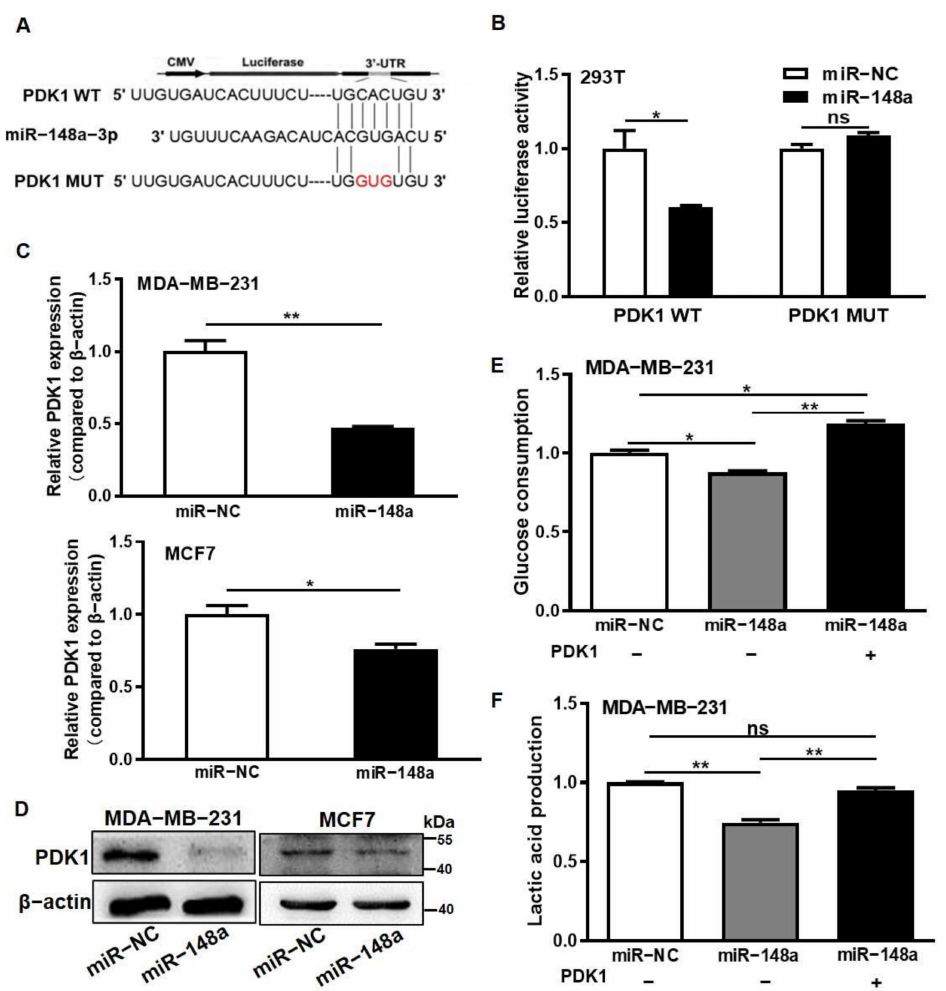
Figure 2. miR-148a was identified for directly suppressing PDK1 expression and inhibiting gly- cometabolism. ( A ) The PDK1 3 (cid:48) -UTR wild-type (WT) and mutant (MUT) reporter constructs con- taining miR-148a-targeting sequences are shown. ( B ) PDK1 WT and MUT 3 (cid:48) -UTR reporter plasmids were constructed, and Firefly/Renilla luciferase activities of the miR-NC and miR-148a groups were measured in the cells by dual-luciferase reporter assay. ( C ) The mRNA levels of PDK1 were detected in miR-148a overexpression cells by qRT-PCR with β -actin as a control. ( D ) The protein levels of PDK1 were measured by Western blotting. ( E , F ) The cultured media from the MDA-MB-231 miR-NC, miR-148a, and miR-148a + PDK1 groups were collected for the measurement of glucose consump- tion and lactate production levels, as described in the Method section. Data were analyzed by the Student’s t -test from three independent experiments in ( B – D ). * Indicates significant difference at p < 0.05, ** indicates significant difference at p < 0.01, and ns means no significant difference. Original Blots see Supplementary File